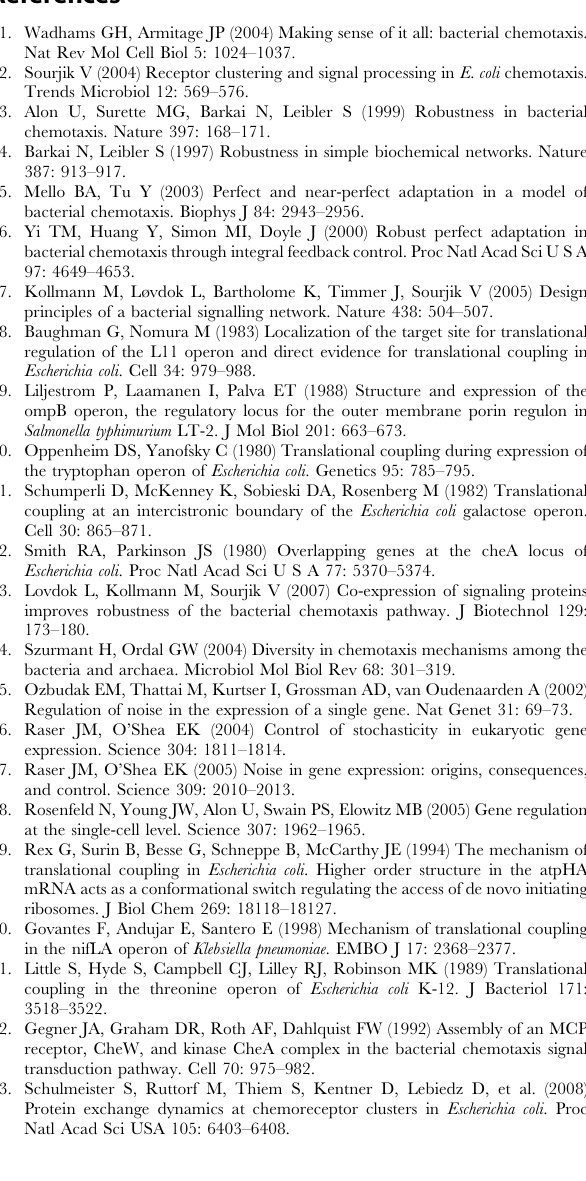
Table S3 Pairwise occurrence of chemotaxis genes in 327 genomes without cheZ